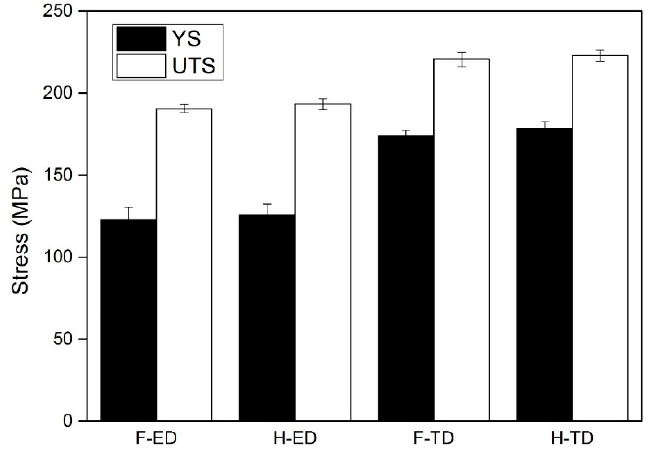
Figure 4. Tensile stress analysis of XK105 (YS: yield stress; UTS: ultimate tensile stress).